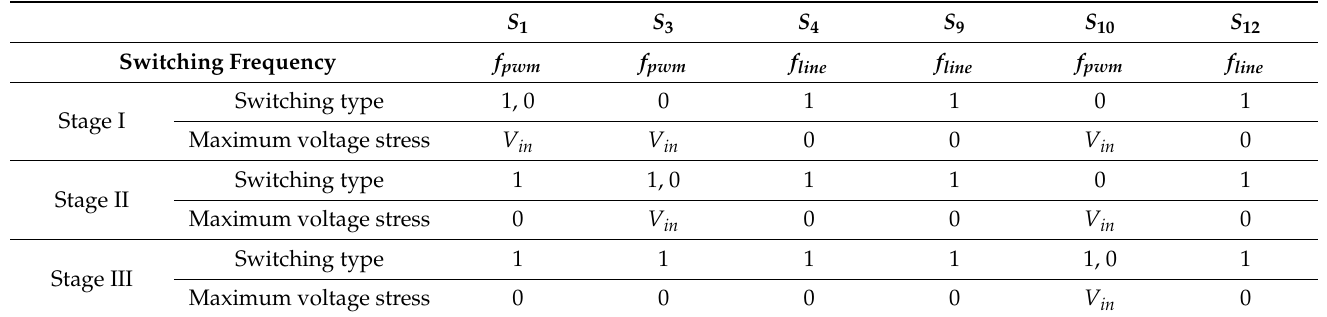
Figure 12. Current flow direction of stage III when switch S 10 is off. Table 1. Switching behavior of the proposed 7-level DC-AC inverter.